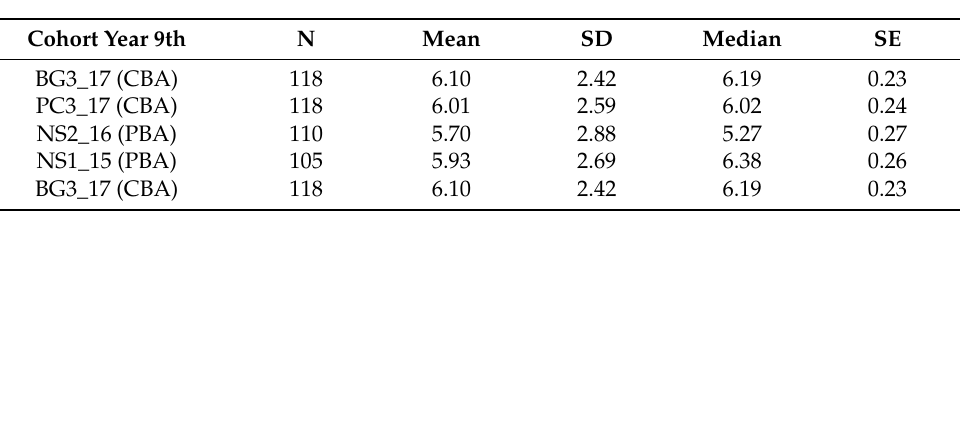
Table 2. Descriptive stats of EOC raw grades earned by the students of cohort Year 9 (Y09) in the four mandatory science subjects studied until that